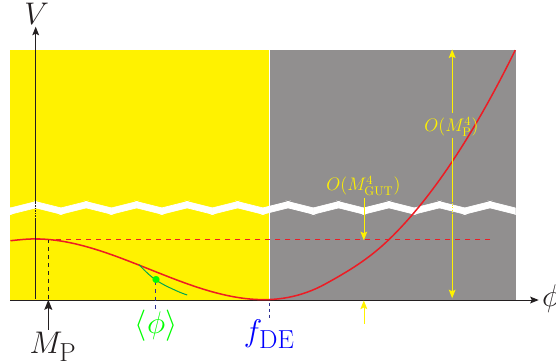
Figure 9. The trans-Planckian decay costant in the hilltop